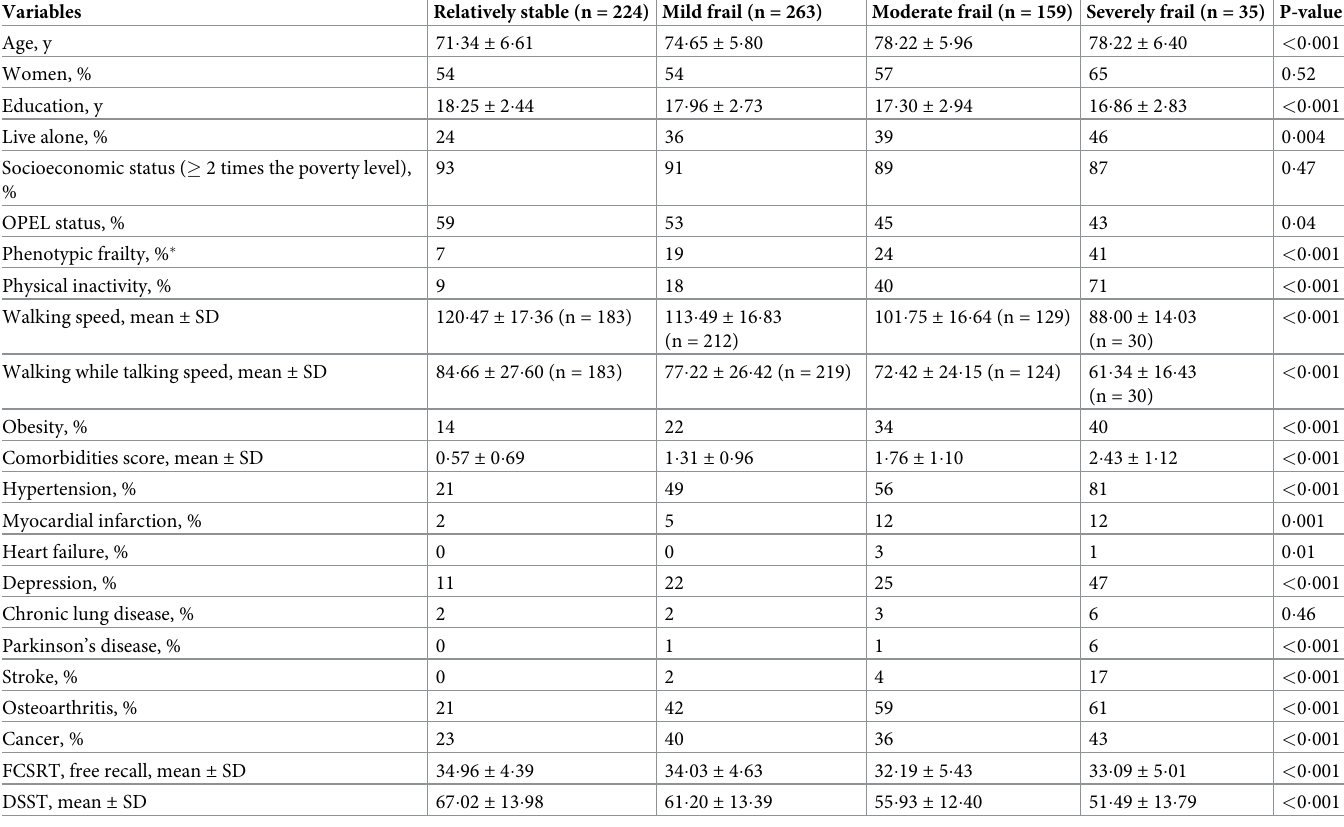
Table 2. LonGenity cohort baseline characteristics by frailty trajectory class. P values for trend.